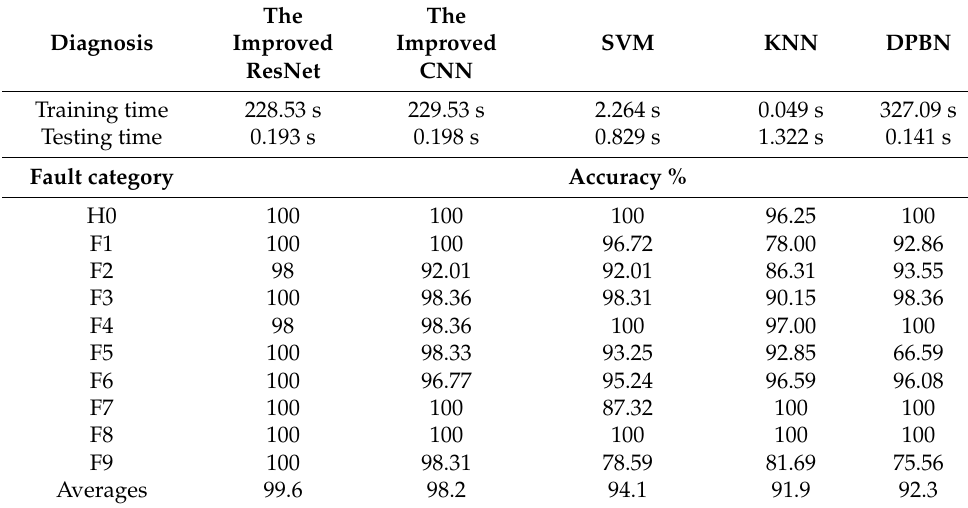
Table 5. A comparison of the proposed method Vs existing